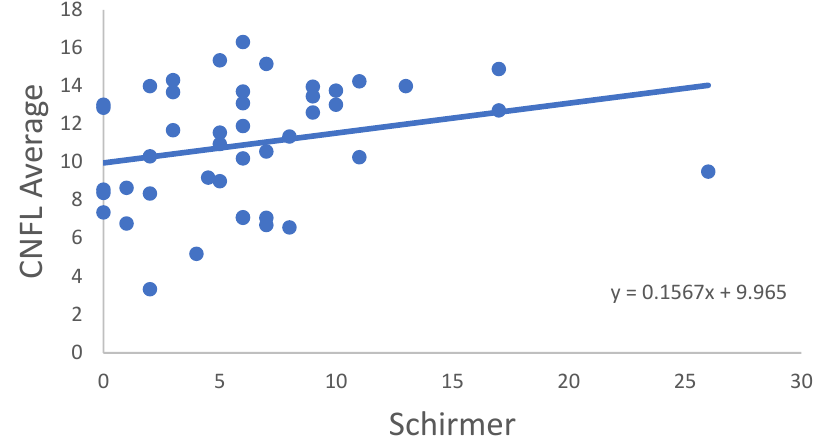
Figure 3. Correlation of CNFL Average and Schirmer’s-test results.